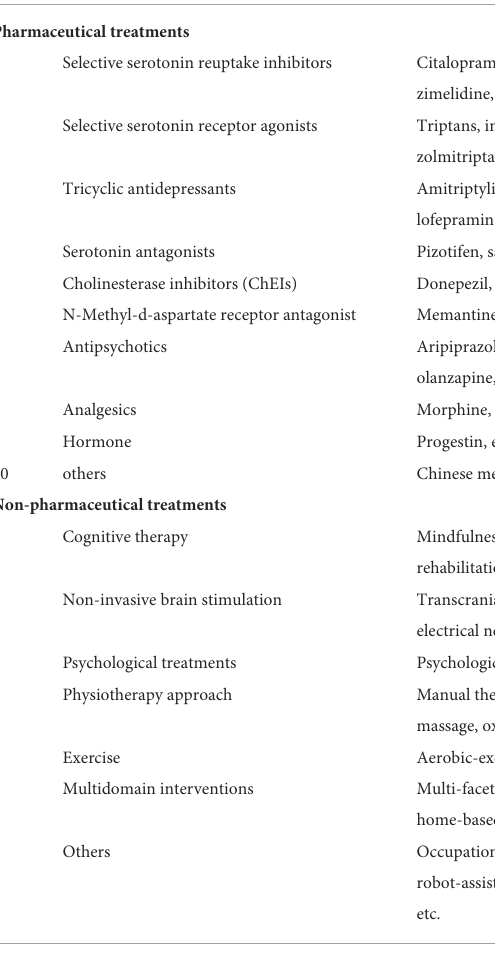
TABLE 1 Potential pharmacological and non-pharmacological interventions.